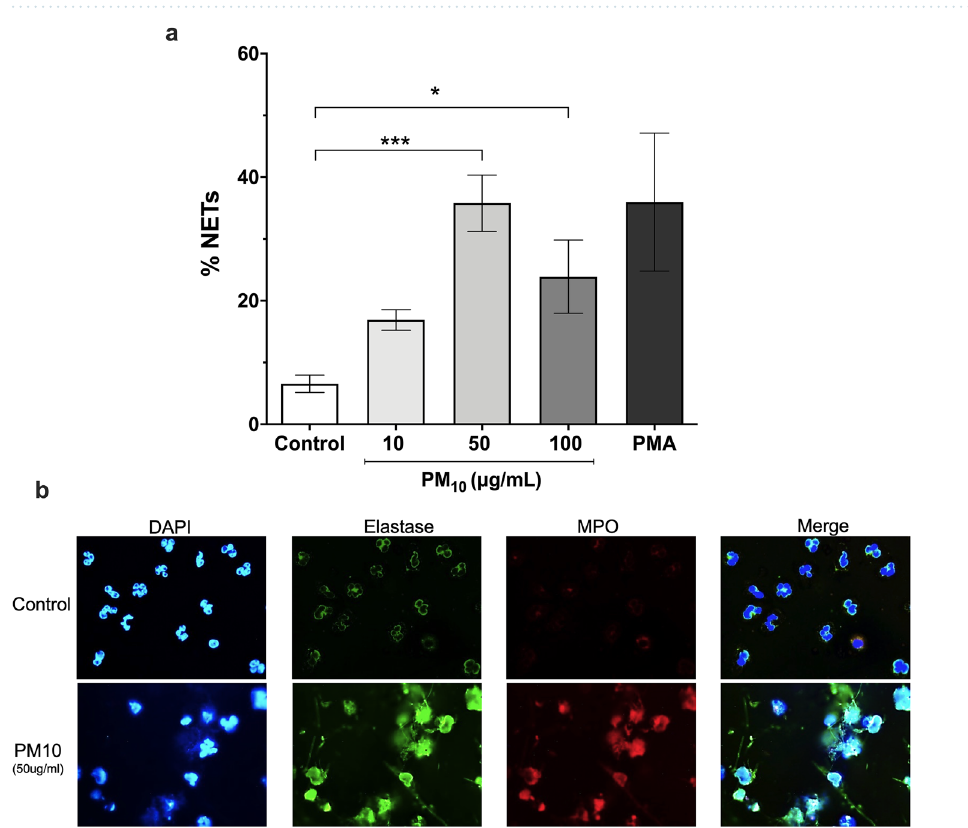
Figure 3. NETs formation in PMNs exposed to PM 10. PMNs were exposed to 10, 50, and 100 μg/mL PM 10 for 3 h. Negative control (culture medium); positive control (PMA). ( a ) NETs release was analyzed microscopically, and MPO, NE, and DNA were quantified with ImageJ software. ( b ) Representative fluorescence microscopy images of NETs. Images show colocalization of MPO (red), NE (green) with DNA fibers released (blue) from released NETs. All data are represented as mean ± SEM of 9 healthy donors. *p < 0.05; ***p < 0.001 by Kruskal– Wallis analysis with Dunn’s post hoc